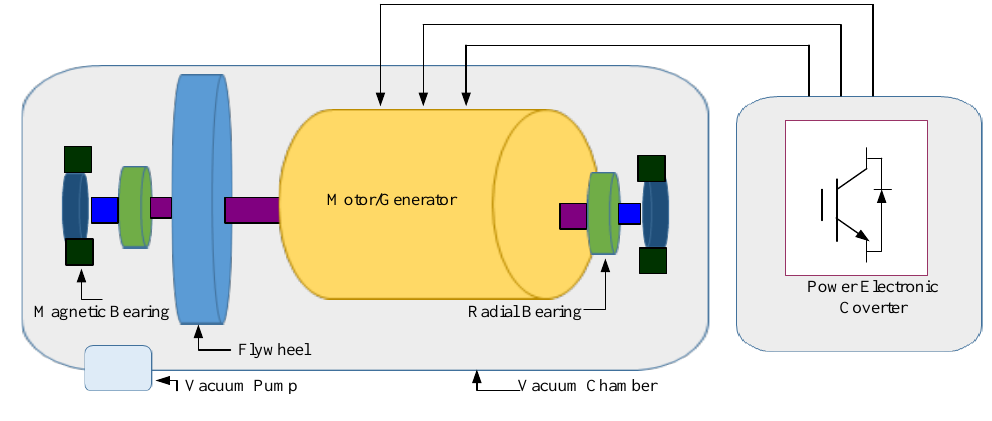
Figure 1. Flywheel Figure 1. Flywheel structure.